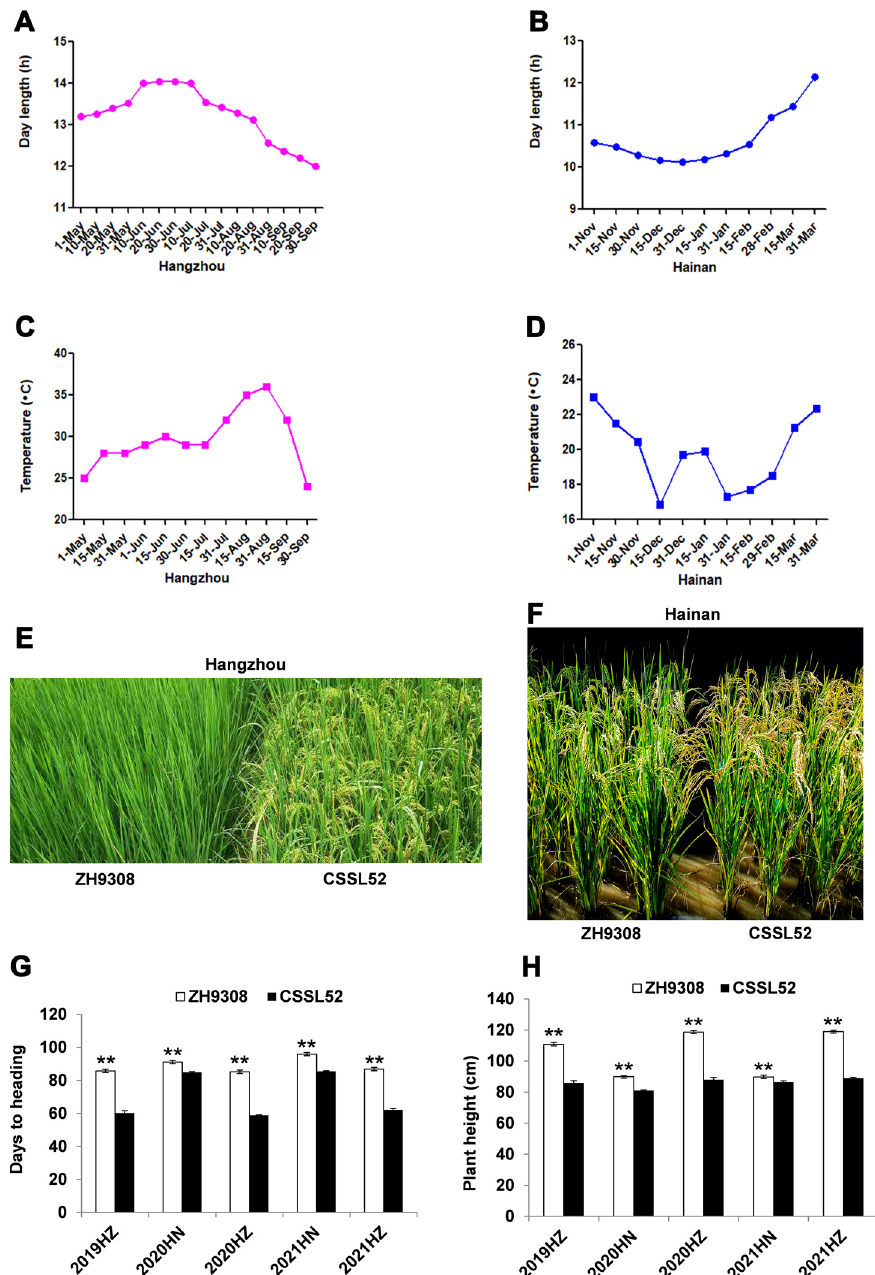
Figure 2. Comparison of heading date and plant height of ZH9308 and CSSL52 under five environmental conditions. ( A – D ) Daily photoperiod ( A , B ) and mean temperature ( C , D ) under Hangzhou and Hainan conditions in 2020 during the rice-growing season. ( E , F ) The phenotype of ZH9308 and CSSL52 under Hangzhou ( E ) and Hainan ( F ). The photo was taken at the CSSL52 heading stage in ( E ) and the CSSL52 maturation stage in ( F ). ( G , H ) Days to heading ( G ) and plant height ( H ) comparison between parents from 2019–2021 under NLD conditions in Hangzhou and NSD conditions in Hainan. The asterisks ** indicate significance between the parents at the p < 0.01, according to Student’s t